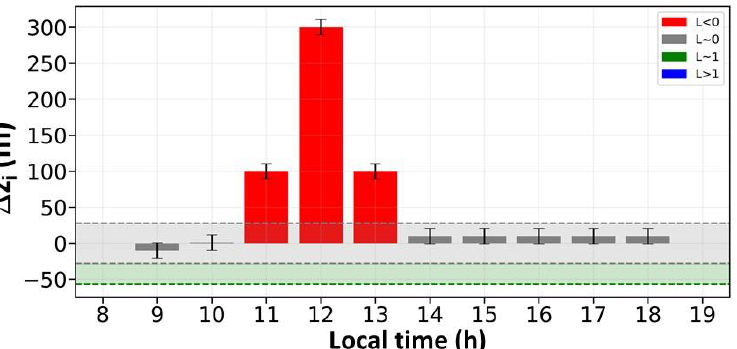
Figure 4. Diurnal evolution of ∆ z i and L on 23 July 2019. Gray and green shadows represent the regions where L tends to 0 and 1, respectively.